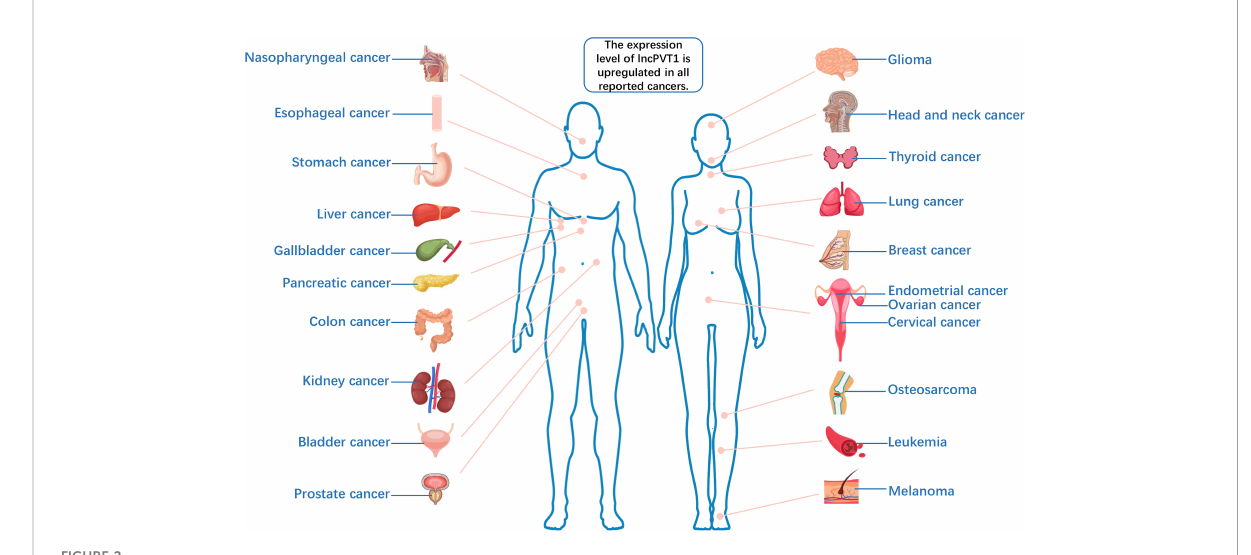
FIGURE 2 The expression level of lncPVT1 is upregulated in all reported